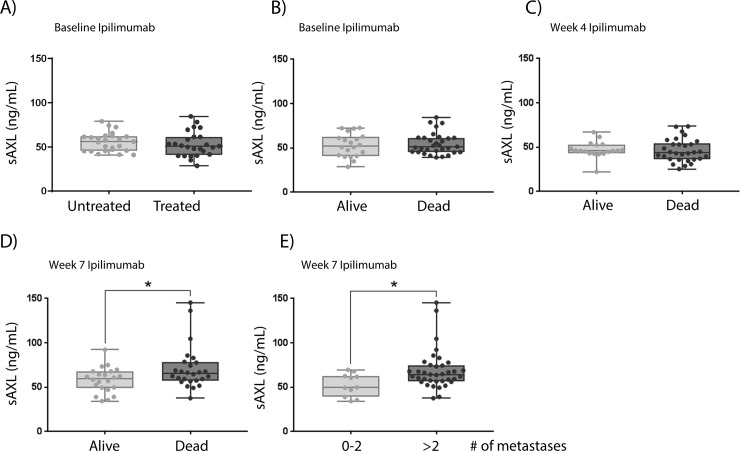
sAXL levels are increased in patients with shorter two-year survival after seven weeks of ipilimumab treatment.A) sAXL levels measured by ELISA in plasma samples in previously treated versus untreated patients at the start of ipilimumab treatment. sAXL levels in serum samples from stage IV patient harvested B) before the start, C) at week 4 or D) at week 7 of ipilimumab treatment grouped according to survival after two years. E) sAXL levels in serum harvested at week 7 of ipilimumab treatment related to number of metastases. sAXL levels were determined by ELISA and run in technical duplicates. The figures are displayed as box and whiskers plot ± range, where each point represents one patient. * = p value ≤ 0.05.